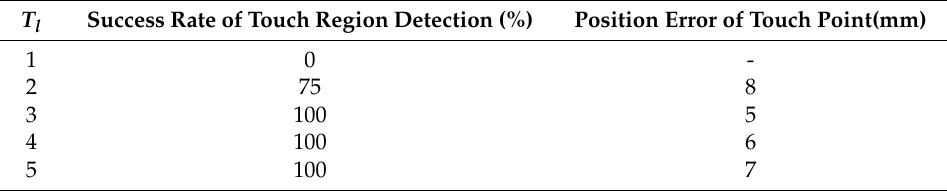
Table 1. Success rate and position errors according to T l in touch region detection. T l